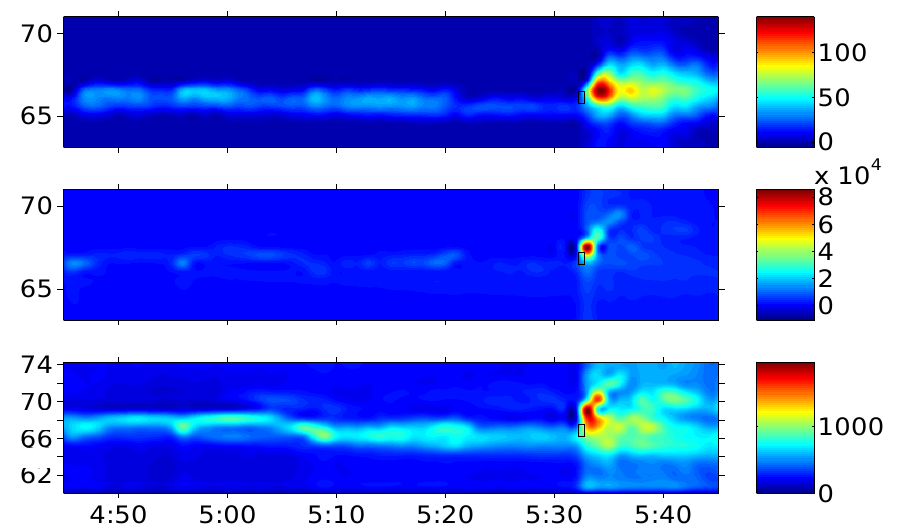
Fig. 1. Meridian scanning photometer keograms from the Gillam photometer on 15 November 1992. The latitudes are expressed in AACGM coordinates, and the brightness scale is measured in Rayleighs. The top panel shows the 486.1-nm emissions, the middle panel shows the 557.7-nm emissions, and the bottom panel shows the 630.0-nm emissions. The location of the onset is indicated by the black boxes in the keograms.